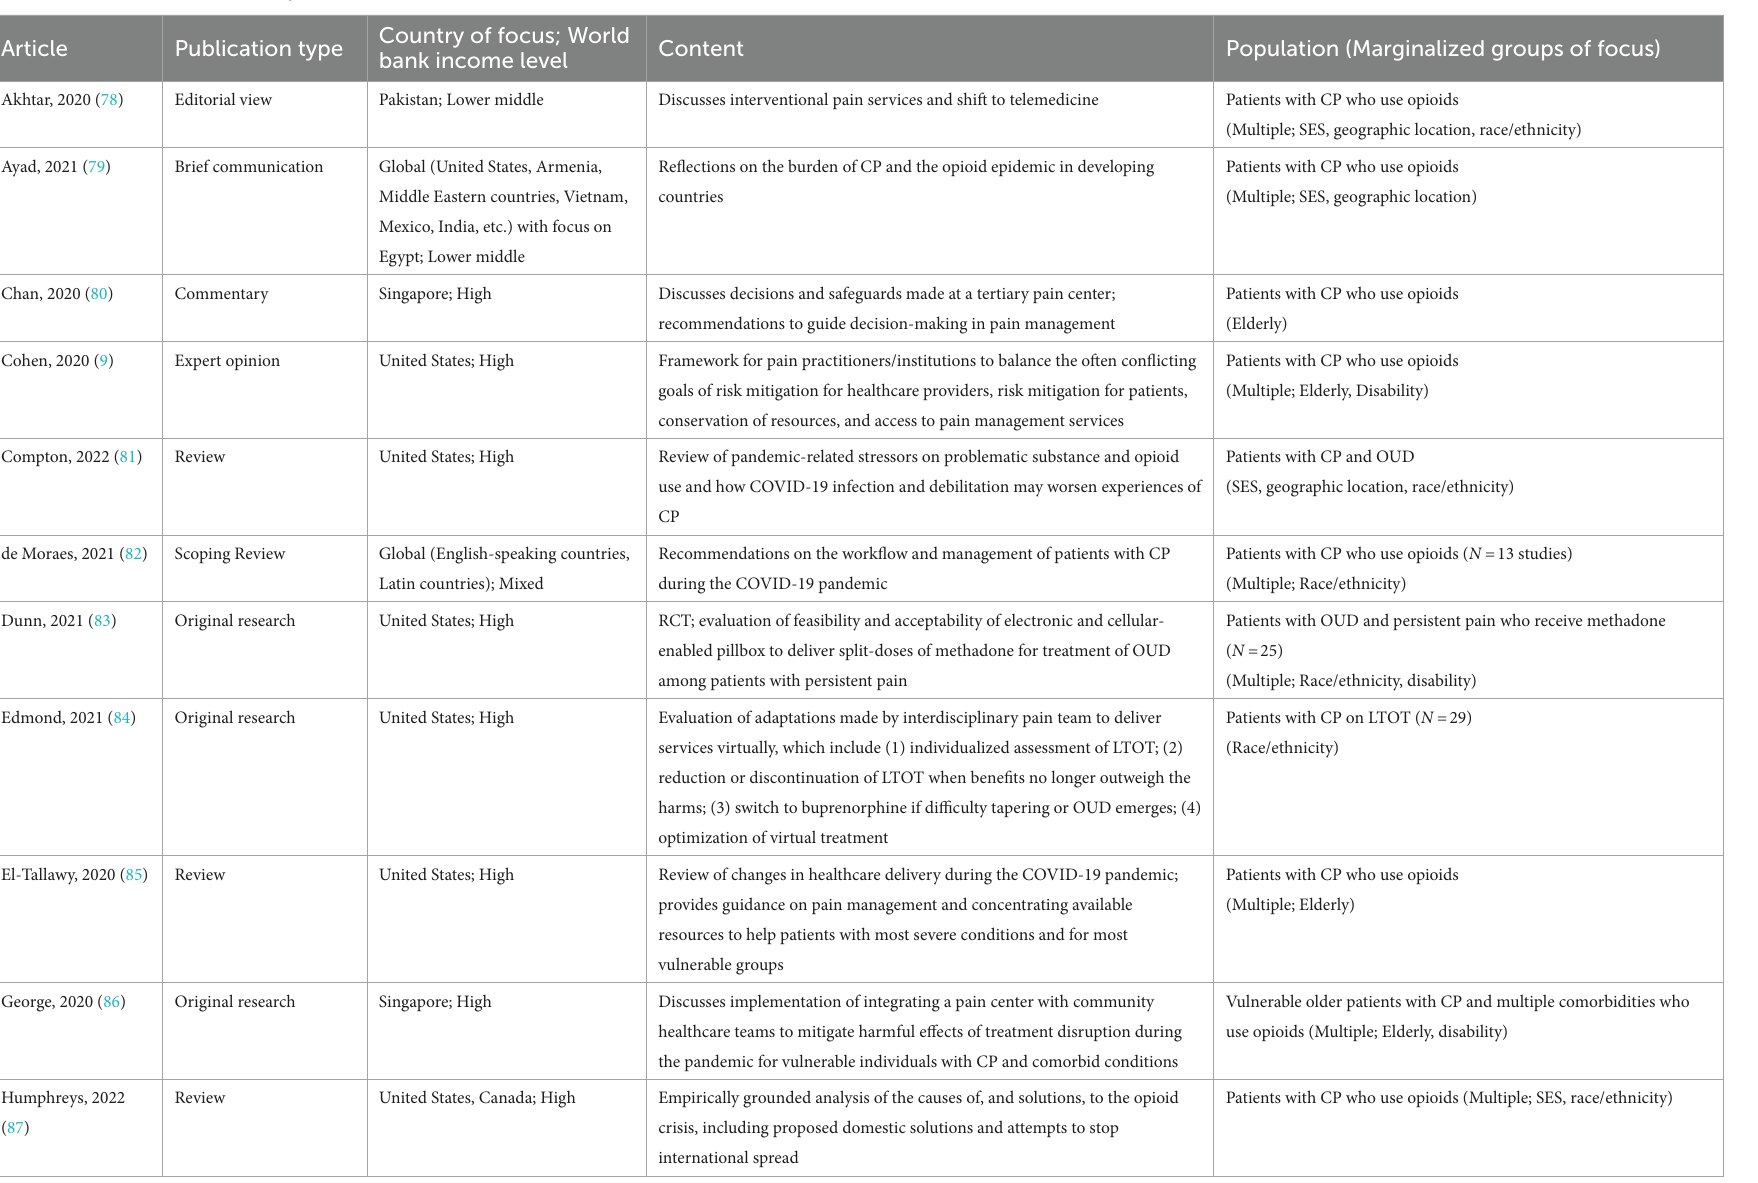
TABLE 2 Characteristics of included